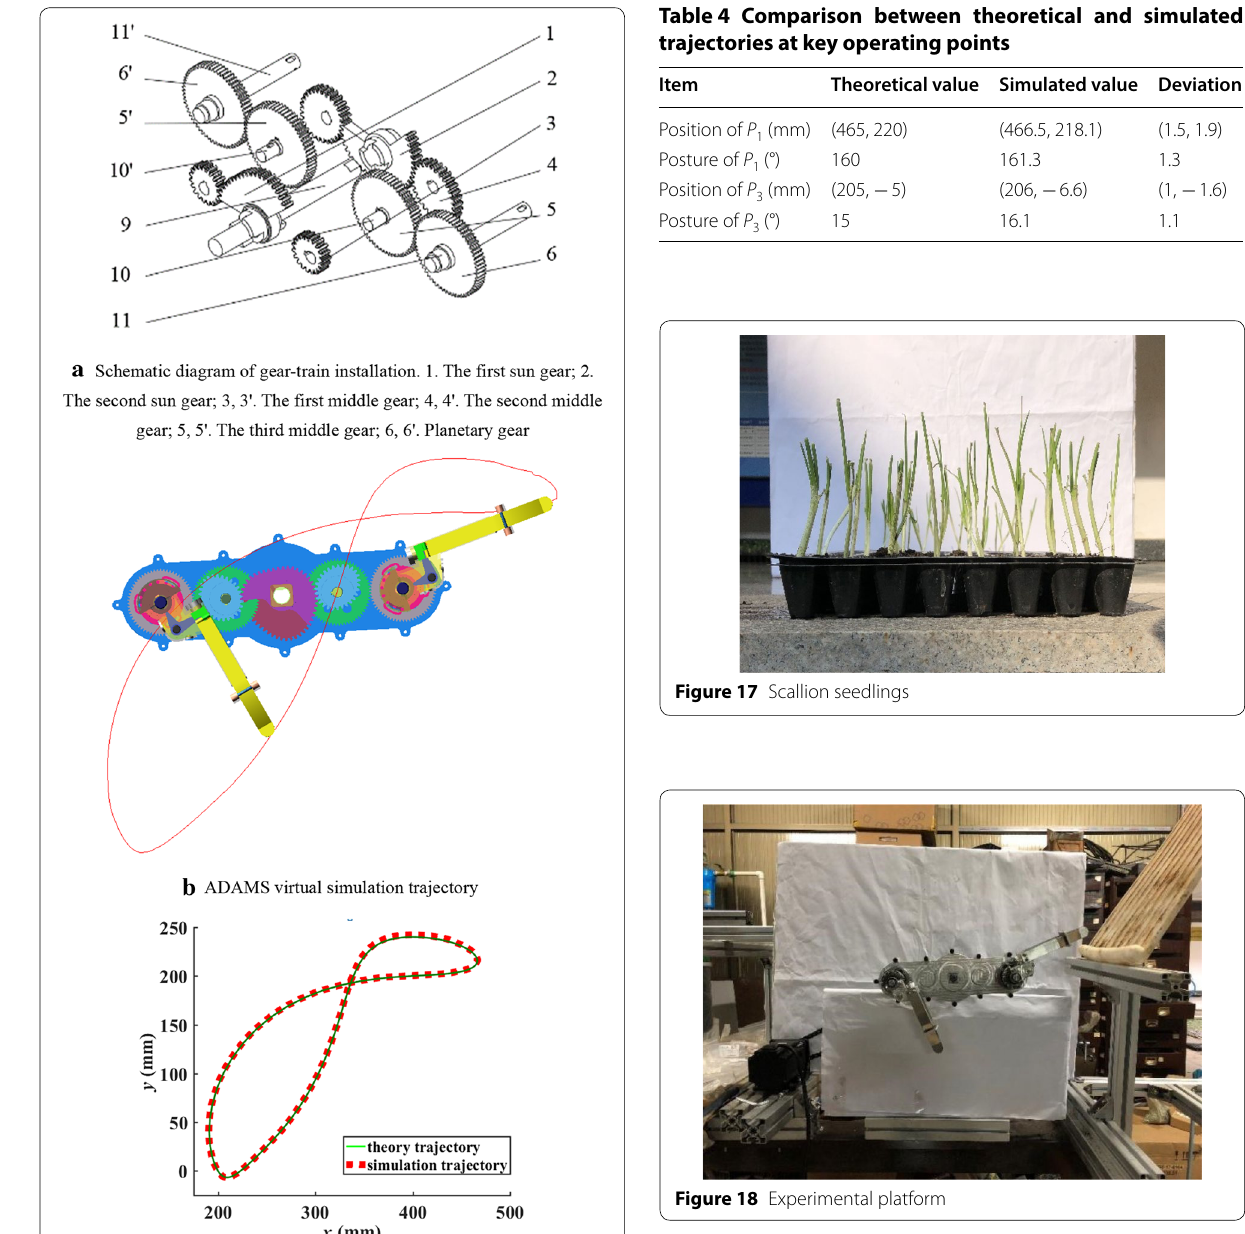
Figure 16 Gear-train model and simulated mechanism track